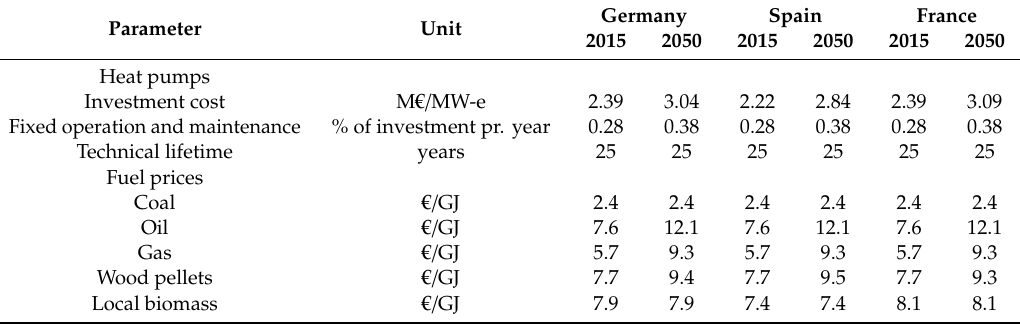
Table 1. Cost assumptions for DH heat pumps and fuel prices for the three countries in 2015 and 2050. Heat pump costs are based on [44] and the fuel price assumptions are based on the World Energy Outlook of the International Energy Agency, “Sustainable development scenario” from 2017